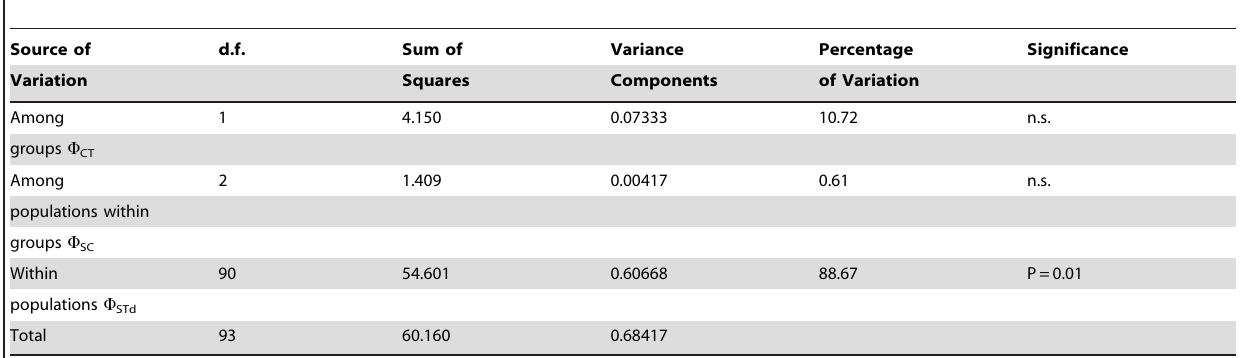
Table 5. AMOVA analysis of mtCOI variation.